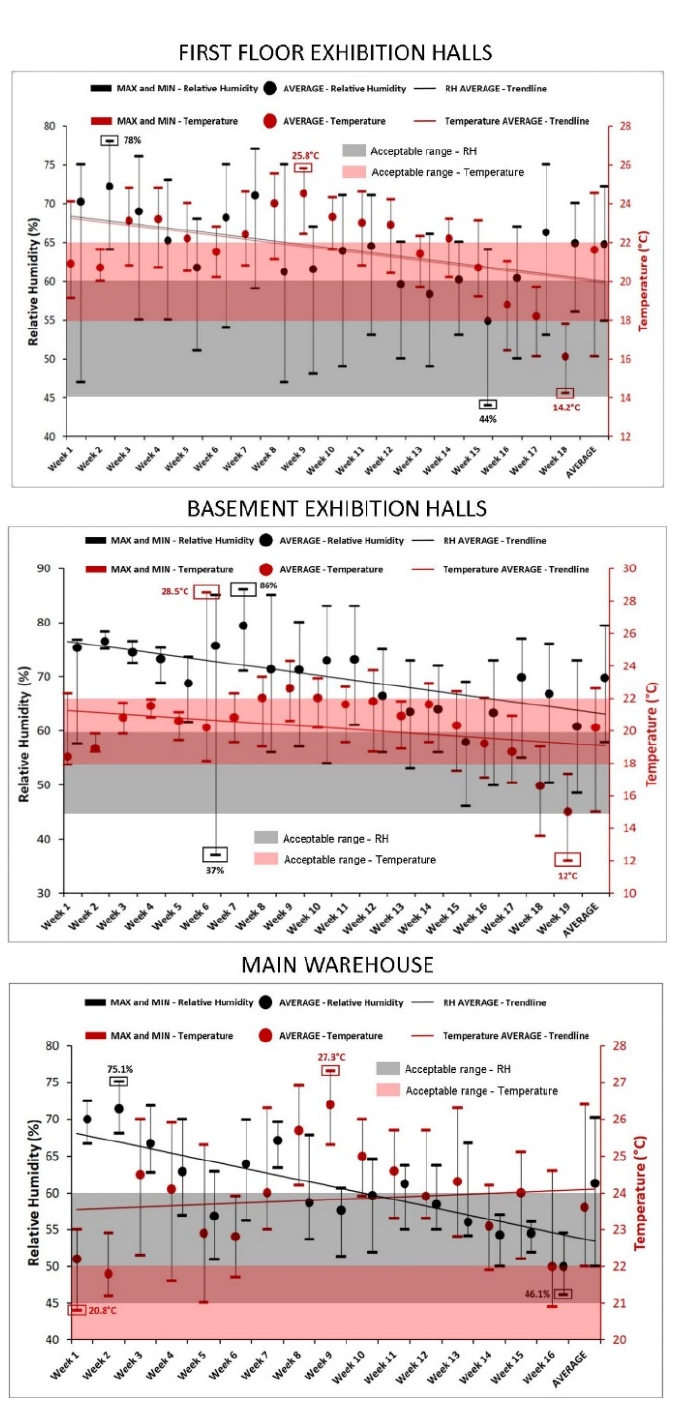
Figure 4. Fluctuations in terms of minimum, maximum, and average values per week for temper- ature and RH in the three monitored halls